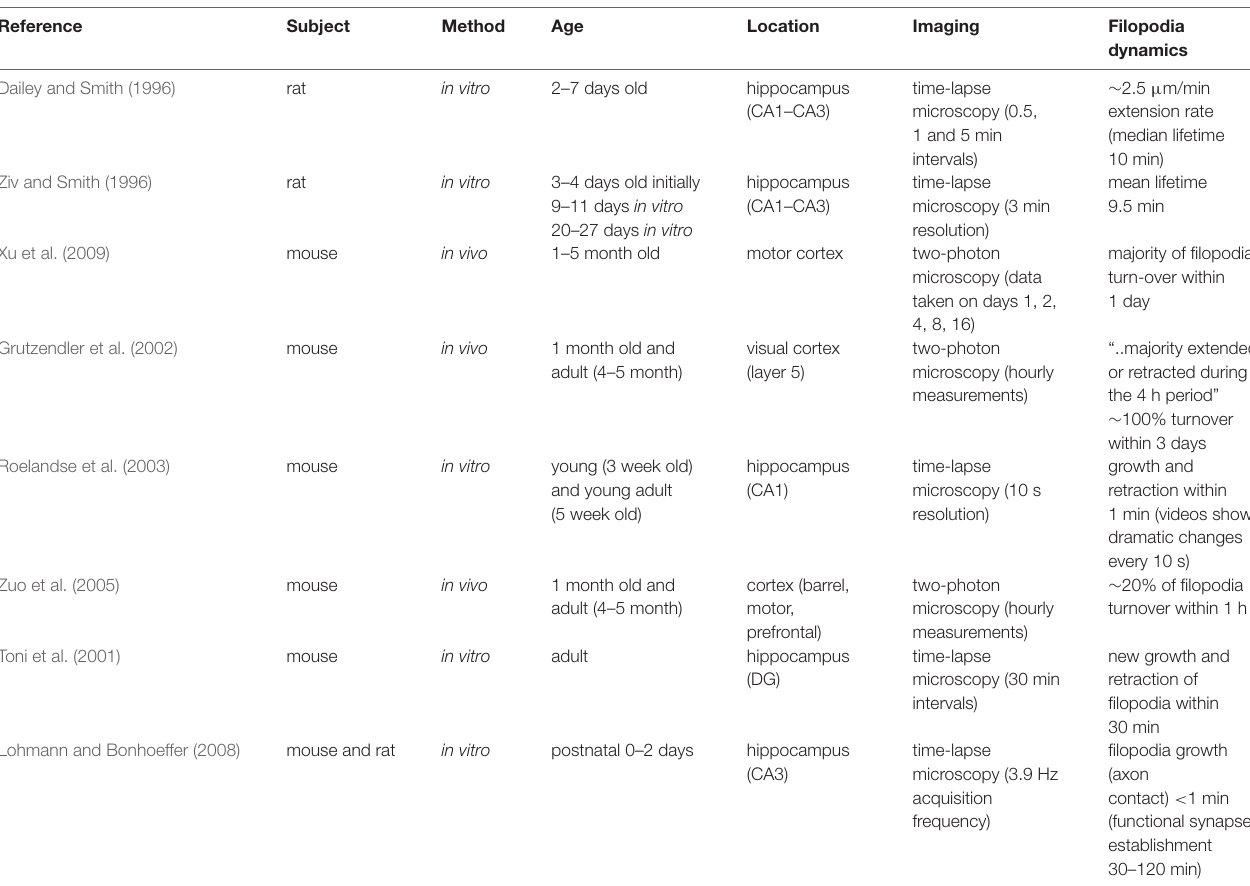
TABLE 1 | Summary of time-dependent studies of filopodia mentioned in the text, ordered chronologically by publication date.